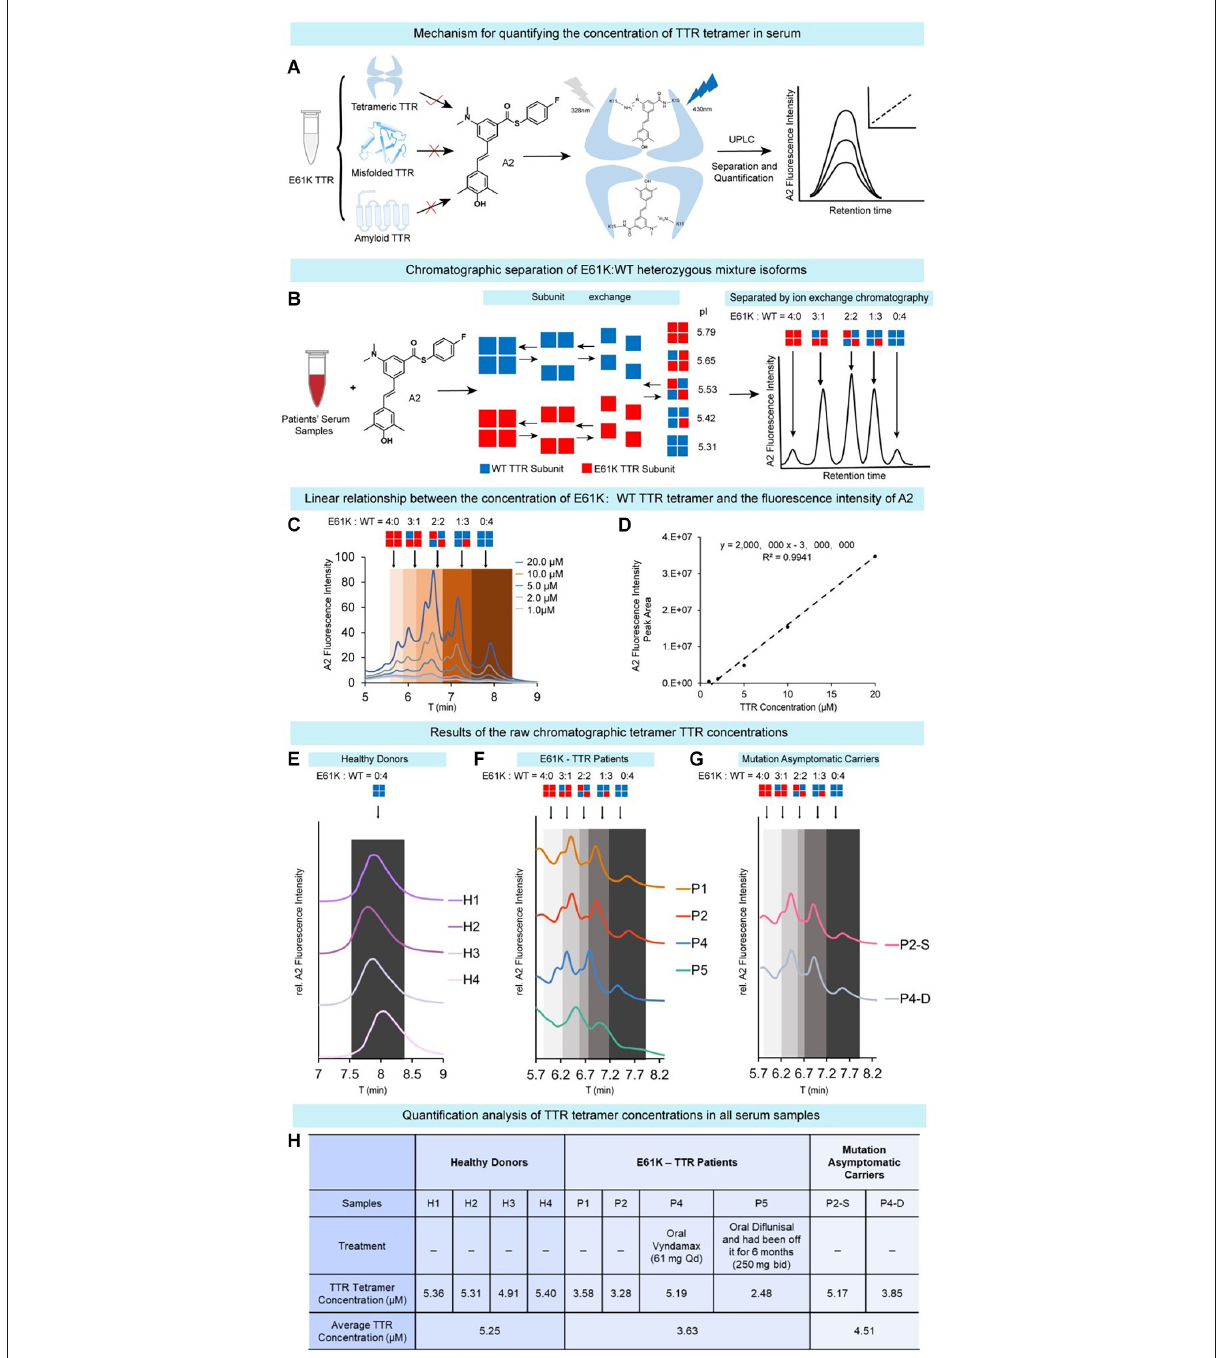
FIGURE5 Quantification of tetrameric TTR concentration inblood serum samples of E61K mutation patients and carriers. (A) The working principle of chromatographic method to quantify tetrameric TTR in serum. The concentration of TTR tetramer in serum was quantified by selectively and exclusively labeling tetrameric TTR using a fluorescence turn-on probe A2 reported by the Kelly group. Using UPLC coupled with fluorescence detector, the concentration of tetrameric TTR can be quantified based on the fluorescence peak signals. (B) Chromatographic separation of E61K:WT heterozygous mixture isoforms. Taking advantage of E to K mutation, the pI values of these mixtures of different subunit ratios are different, leading to their separation on a ion-exchange chromatography. (C,D) Linear relationship between the concentration of recombinant E61K TTR tetramerlabelled by A2 probe and A2 fluorescence peak intensity. (E–G) The raw chromatographic tetramer TTR concentration results from four healthy donors (E) , four E61K-TTR patients (F) , and two mutation asymptomatic carriers (G) on UPLC detected by